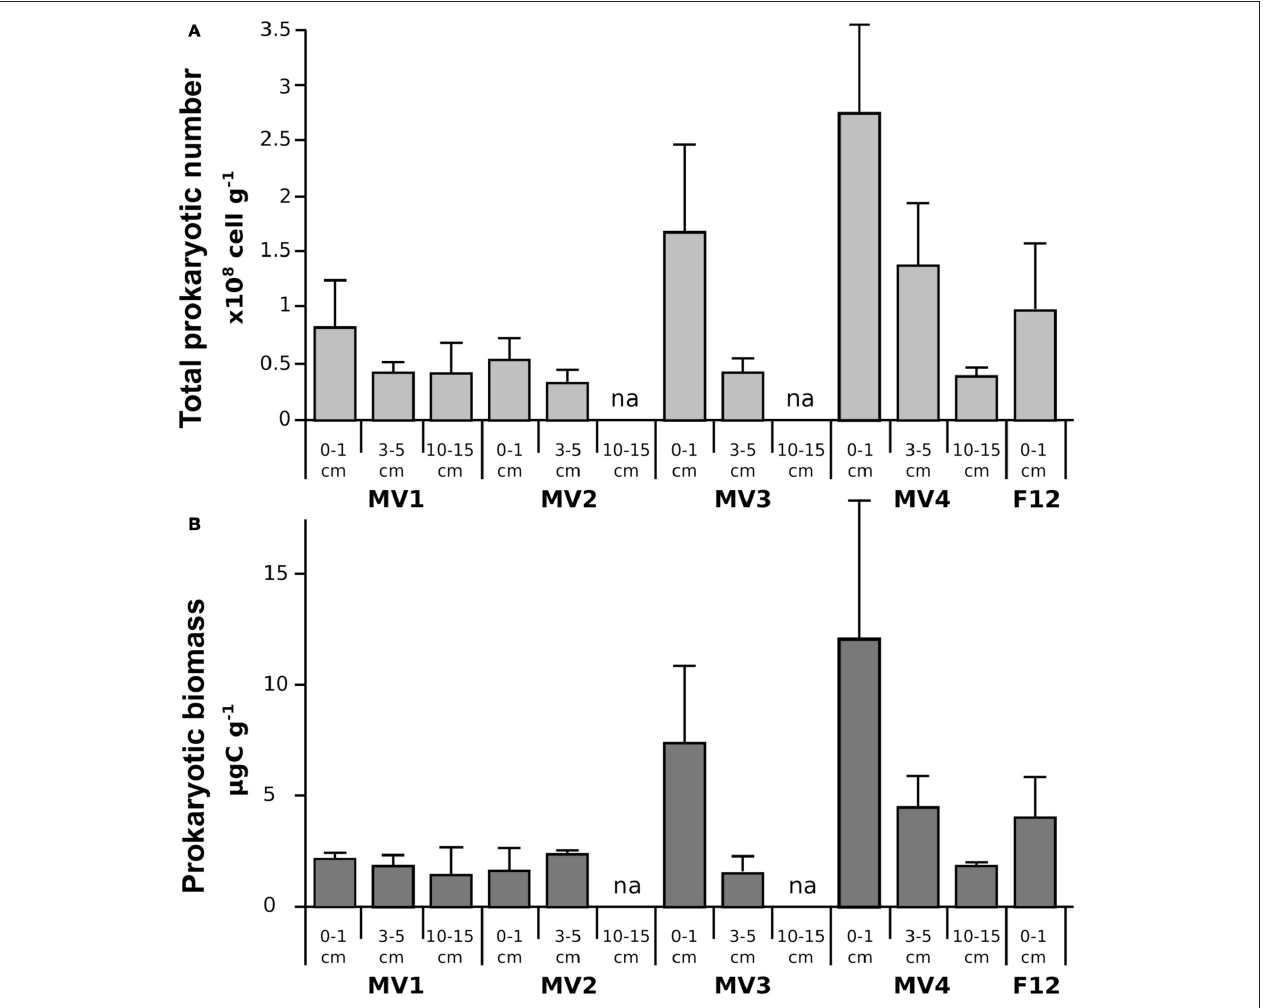
FIGURE 2 | Prokaryotic abundance (TPN; A) and biomass (PBM; B) along the sampled stations. Mean values are reported with standard deviation. na = data not available.